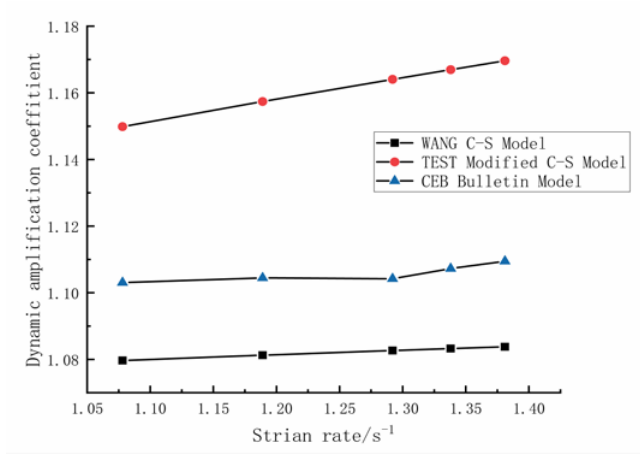
Figure 8. Comparison of DIF y.